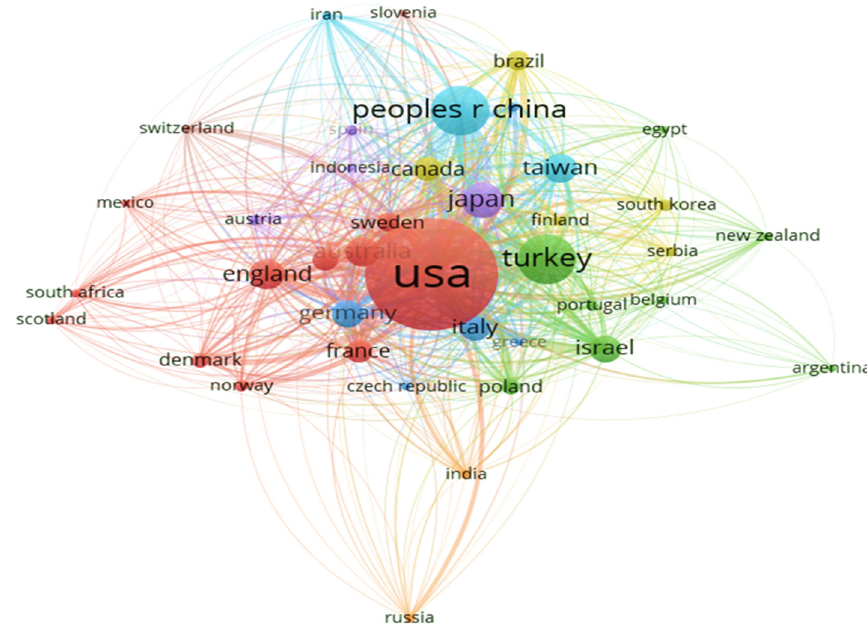
Figure 3. VOSviewer network visualization of research collaborations among countries.